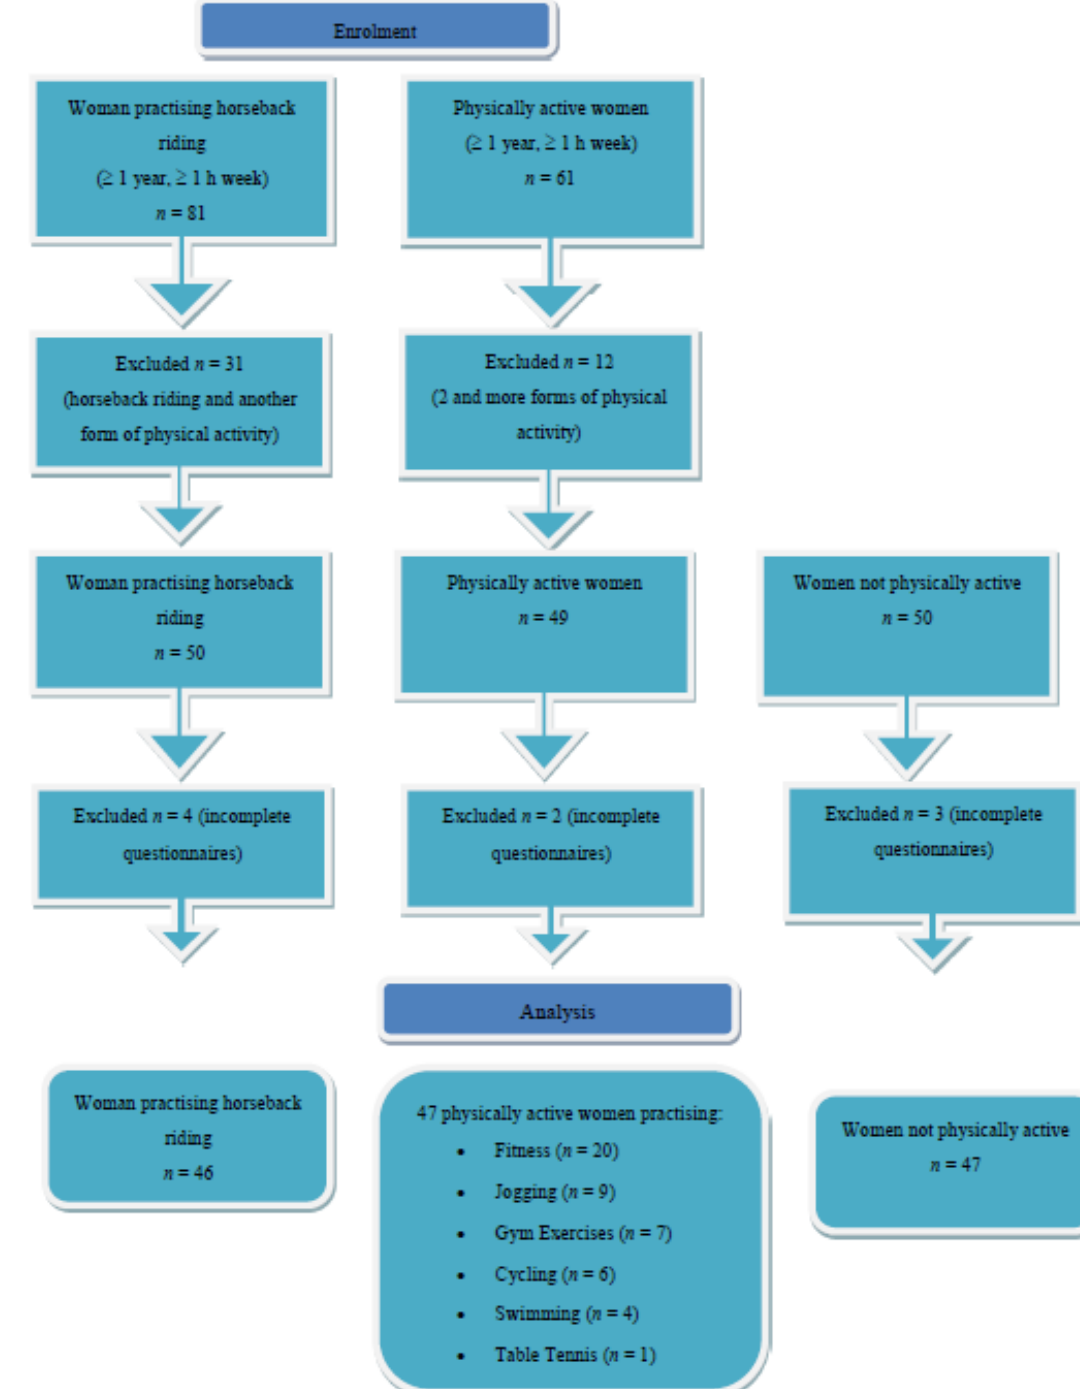
Figure 1. Flow diagram of the study phases.